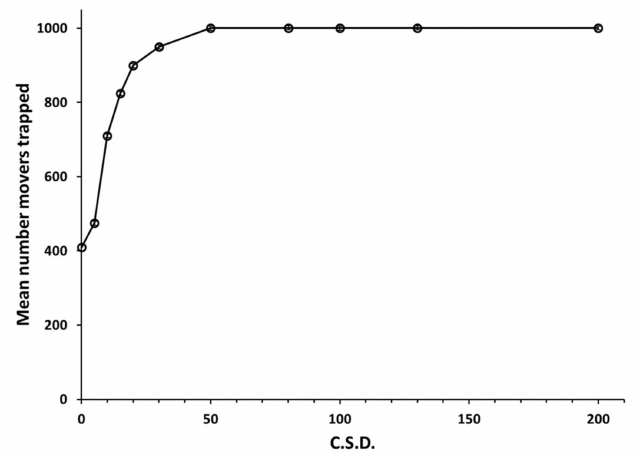
Figure 1. Mean capture of populations of 1000 random walkers released near the center of a 7 × 7 grid of 2 × 2 unit traps evenly spaced 20 units apart, as a function of circular standard deviation (c.s.d.). All movers were captured at c.s.d. 50 ◦ and above. S.E.M. bars around means are so tiny as to be barely